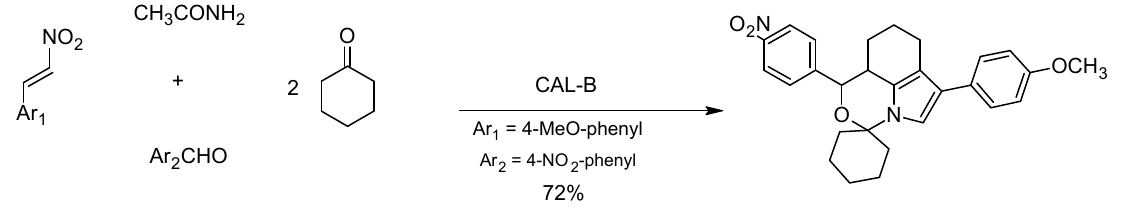
Scheme 22. Enzyme-catalyzed 5-component synthesis of spiro-oxazino derivatives.